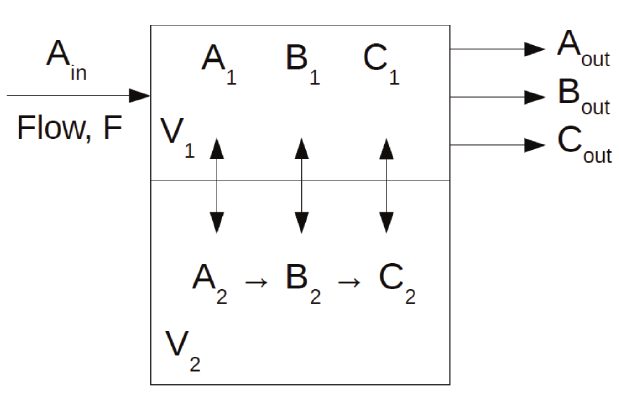
Figure 1. Two compartment, three species model (A, B, C) with volumes V , V , respectively. A is the concentration of A entering 1 2 in compartment 1 through which the flow is F. There is no flow in V but there are the reactions A-->B and B-->C. Passive exchange between compartments occurs for all three